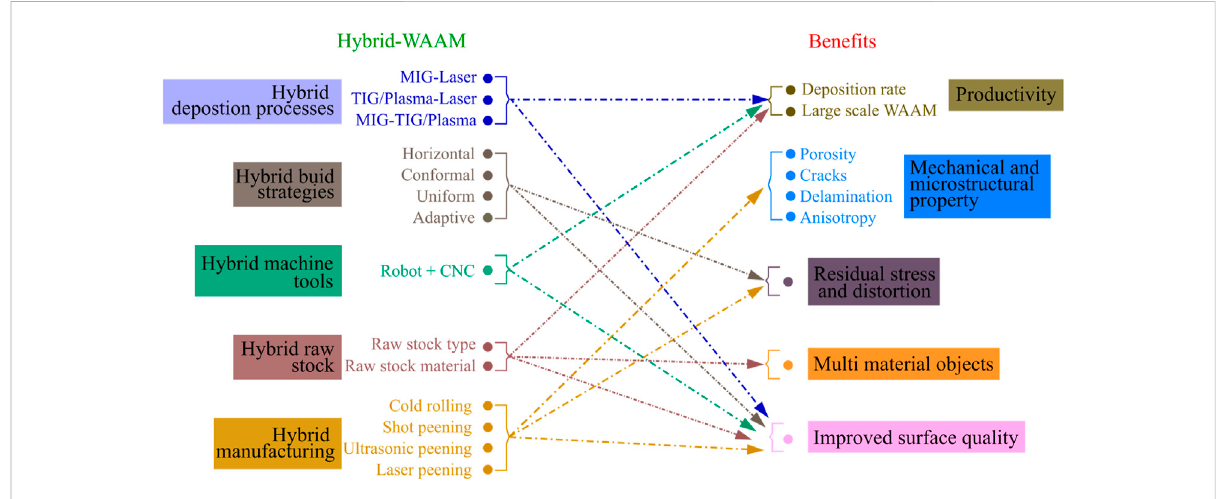
FIGURE 16 Bene fi ts associated with different hybrid-WAAM